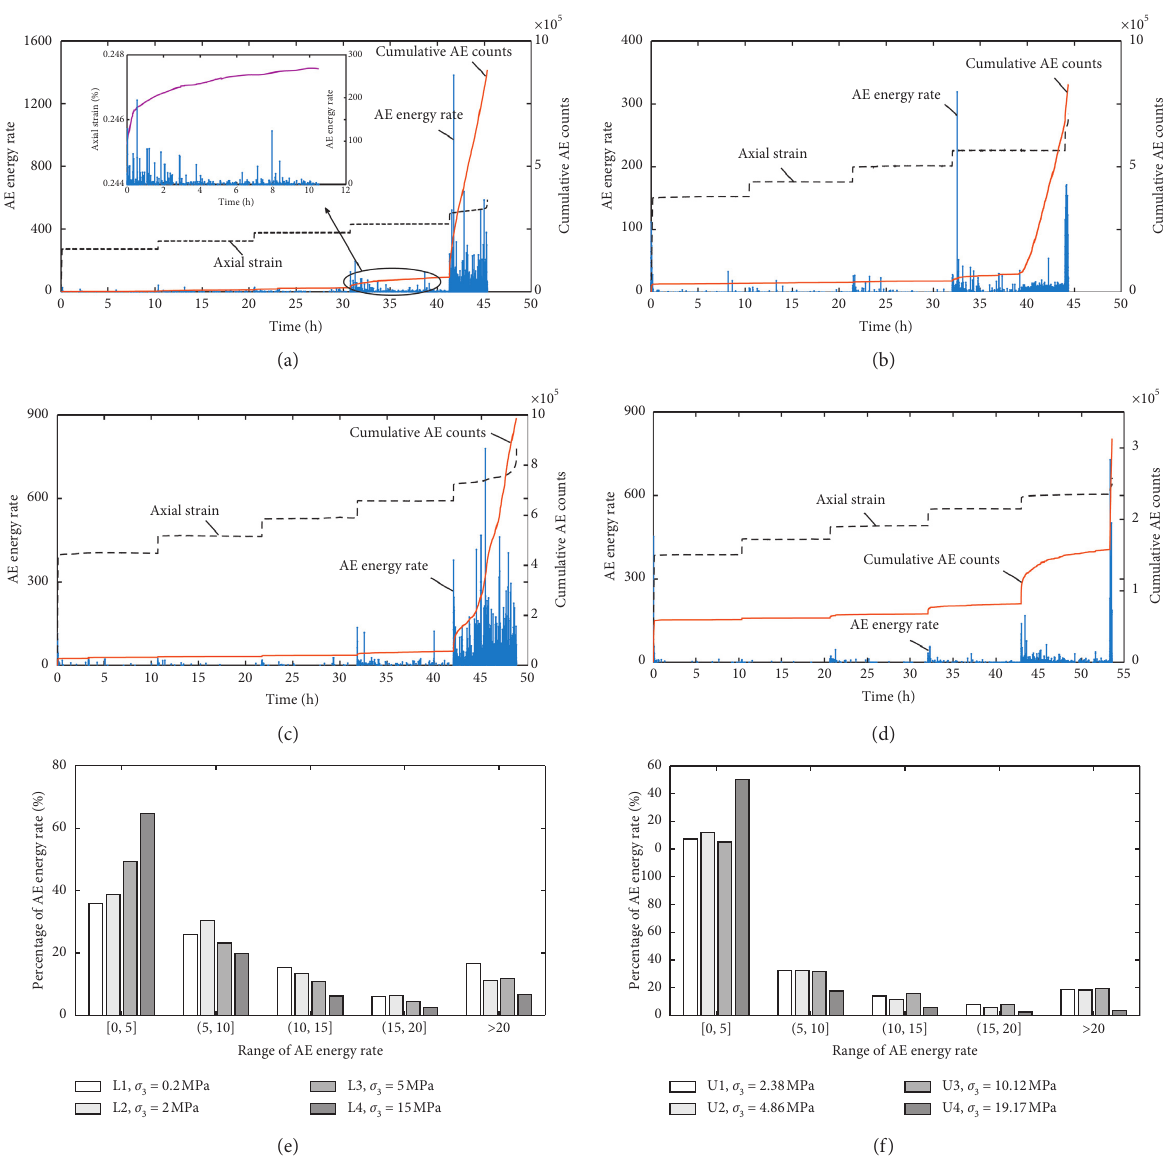
Figure 10: AE characteristics of cracked specimen during creep test. (a) Specimen U1, σ Specimen L2, σ 3 � 2 MPa. (d) Specimen L4, σ 3 � 15MPa. (e) Energy distribution (loading-cracked). (f) Energy distribution (unloading-